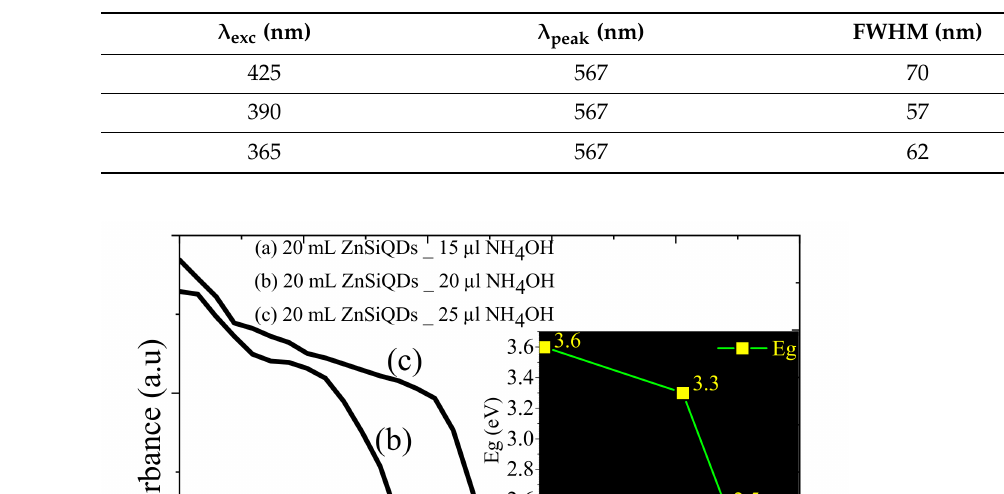
Table 2. Dependence of the emission peak wavelength and the corresponding spectral full width at half-maximum ZnSiQDs on the excitation wavelength changes.